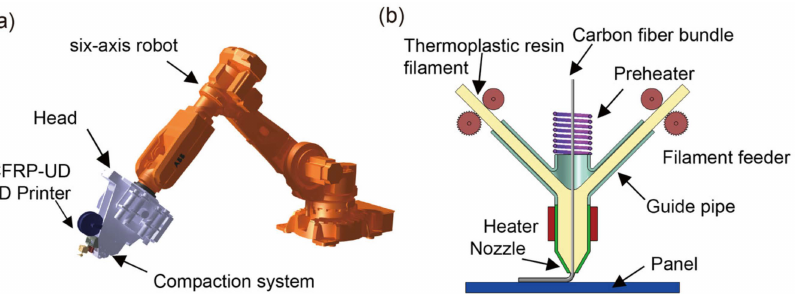
Figure 12. Robot arm for additive manufacturing. ( a ) Simplified model of a robot with integrated 3D printer and ( b ) Multifilament 3D printing using continuous fiber (Open Access, Ref. [174]. 2018,